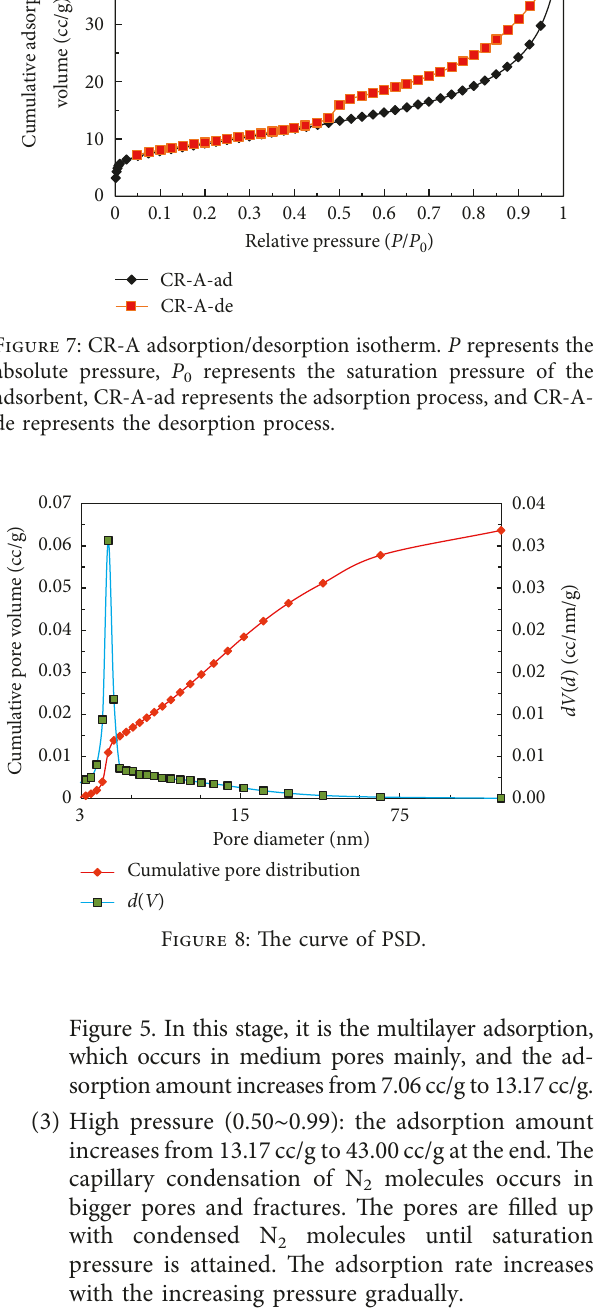
Figure 5. In this stage, it is the multilayer adsorption, which occurs in medium pores mainly, and the ad- sorption amount increases from 7.06 cc/g to 13.17cc/g.